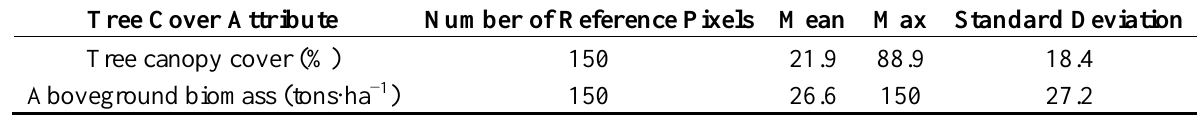
Table 5. Descriptive statistics of the reference